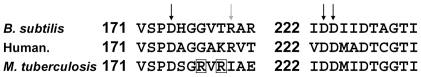
Alignment of free ion binding site sequences.Alignment of free ion binding site sequences of B. subtilis, human PRS1 and M. tuberculosis PRPPases was performed with Multalin 5.4.1. Black arrows point to the aspartic residues involved in the binding of the free ion, grey arrow to the Arg180 (B. subtilis numbering). The boxes highlight the positions of the two arginines in the MtbPRPPase sequence.